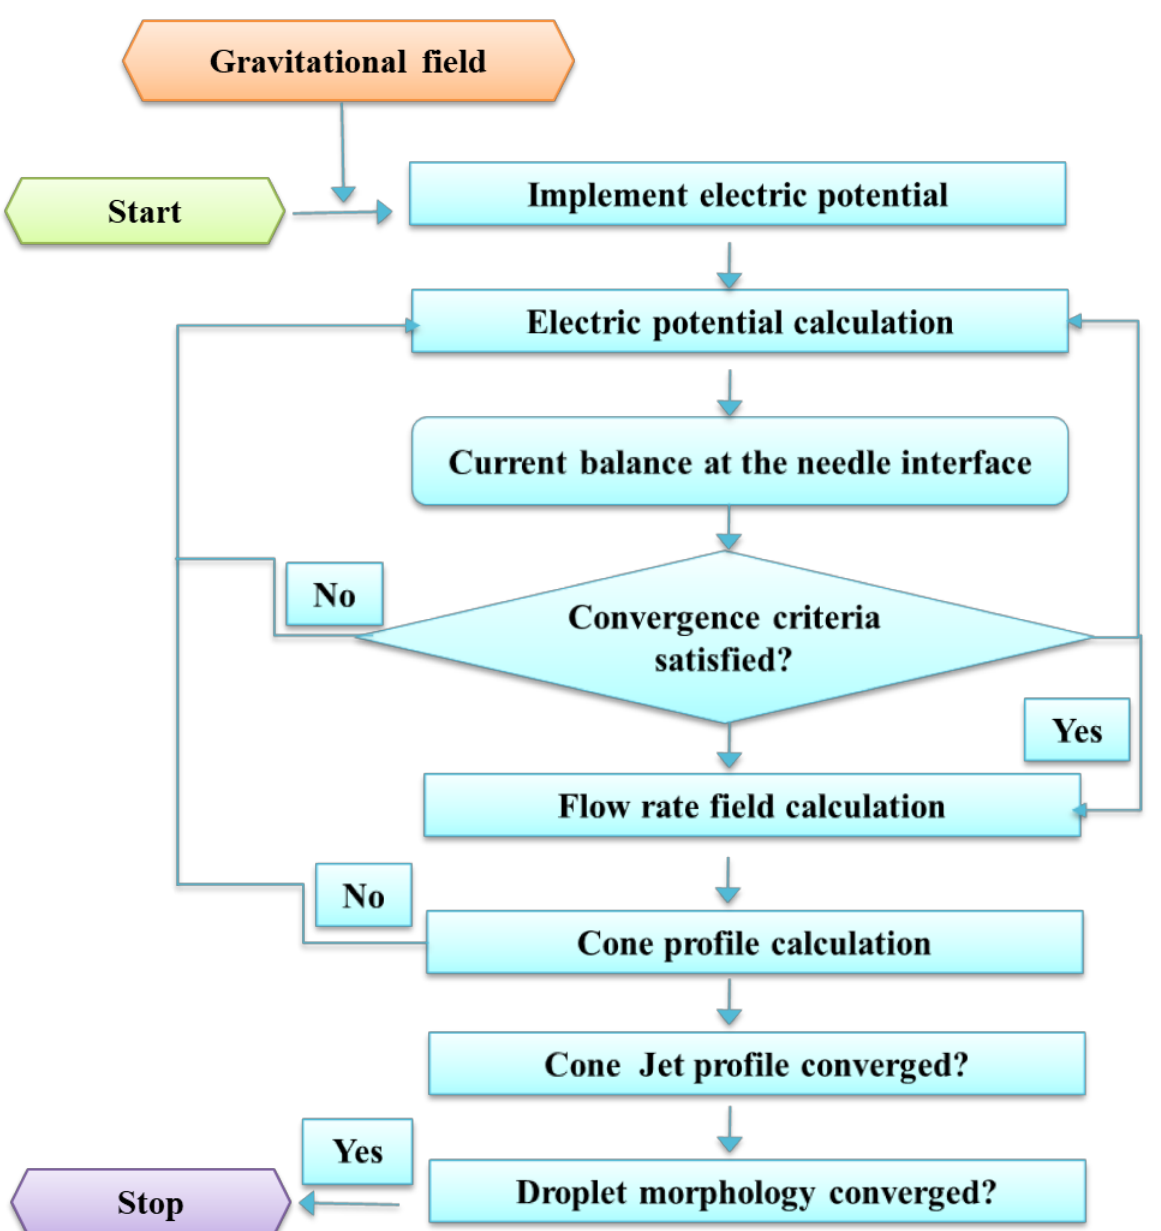
Figure 3. Flow diagram of the numerical simulation model. The formation of DoD CE-Jet mainly depends on the flow of the outer liquid and the distribution of electric filed in the phase field method. Charge density of electric potential around the outer liquid affects the physical properties of silicon oil, which produces stable CE-Jet around the needle tip. Meanwhile, the CE-Jet is concentrated in the region close to the symmetric axis and converts to the micro-dripping mode to produce microdroplets. This is the change of electric field and the flow of fluid almost only occurred in the region around the axis of symmetry. In this situation, meshes located merely in the region approaching the axis of symmetry are required to be refined by applying the user-controlled sequence type, which can help to improve the efficiency and accuracy of the